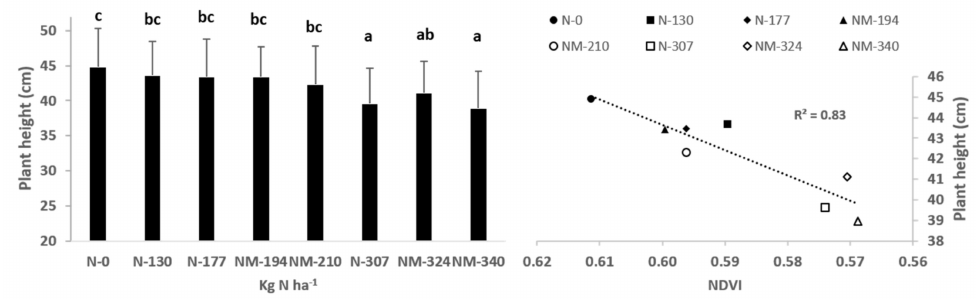
Figure 8. Plant height measured in mid-December ( left ) and the relationship obtained between NDVI and plant height at 62 days after sowing ( right ).